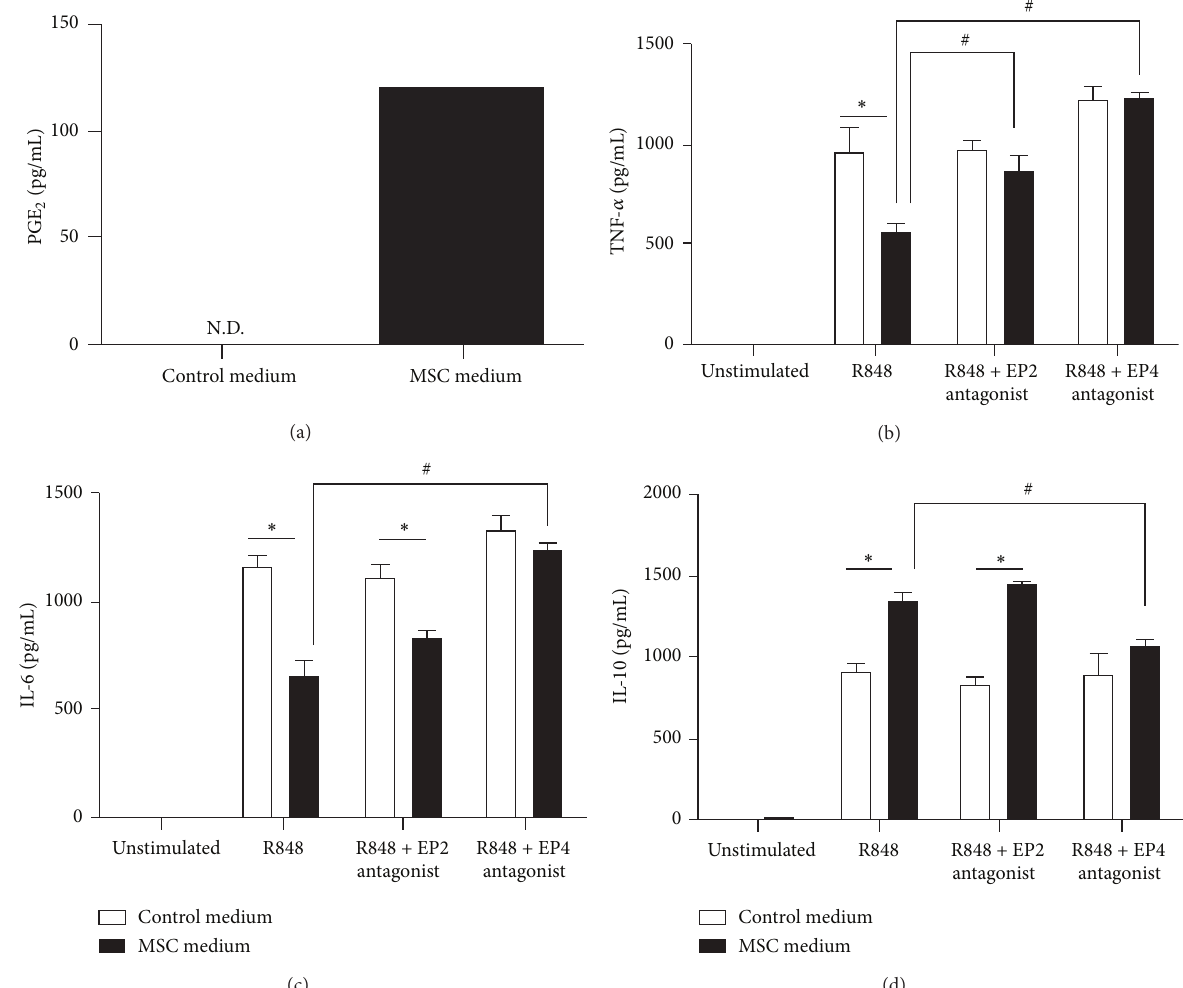
Figure 3: Contribution of PGE 2 /EP to the modulation of cytokine expression in BMDMs incubated in MSC-conditioned medium and then subjected to R848 stimulation. (a) PGE2 levels in MSC-conditioned medium or control medium were measured by ELISA. N.D., not detected. (b–d) BMDMs were incubated in MSC-conditioned medium or control medium with EP2 antagonist (AH6809, 10 𝜇 M) or EP4 antagonist (GW 627368X, 10 𝜇 M). DMSO was used as the vehicle for each EP antagonist. After 1h, R848 (TLR7/8 ligand, 10 𝜇 g/mL) was added, and the BMDMs were incubated for an additional 24 h. The levels of TNF- 𝛼 (b), IL-6 (c), and IL-10 (d) were determined using ELISA. ∗ 𝑃 < 0.05 , compared to the control medium group. # 𝑃 < 0.05 , compared to the R848-stimulated cells (without EP antagonist). Data are expressed as the mean ± SEM. 𝑛 = 3 in each group. Results are representative of 3 independent